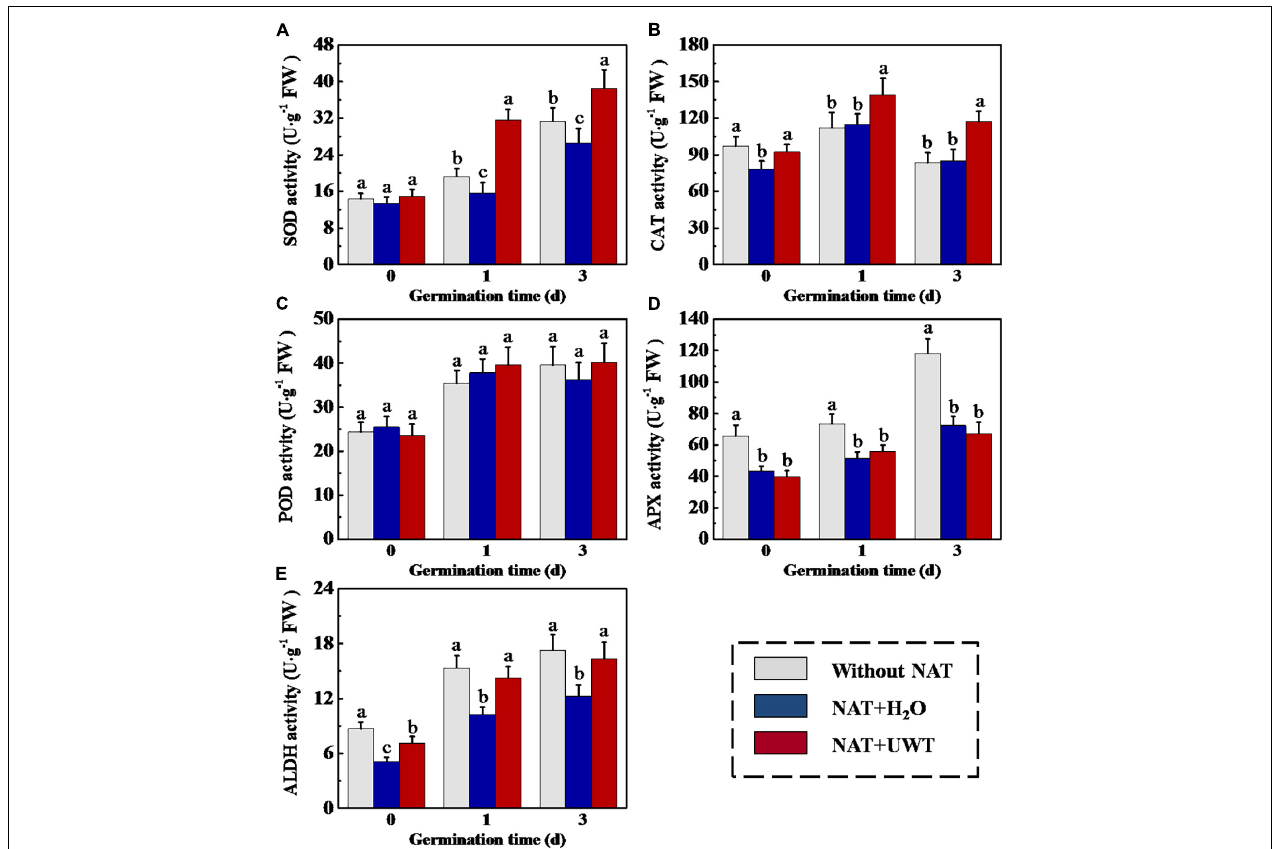
FIGURE 4 | Ultrasonic waves treatment increased the activities of SOD (A) , CAT (B) , POD (C) , APX (D) , and ALDH (E) of aged soybean seeds during early germination. Without NAT, fresh seeds without naturally aging treatment (NAT); NAT + H 2 O, Seeds stored for 12 months with H 2 O; NAT + UWT, NAT seeds with ultrasonic waves treatment (UWT). SOD, superoxide dismutase; CAT, catalase; POD, peroxidase; APX, ascorbate peroxidase; ALDH, acetaldehyde dehydrogenase. Different lowercase letters indicate significant differences between different treatments ( p < 0.05).